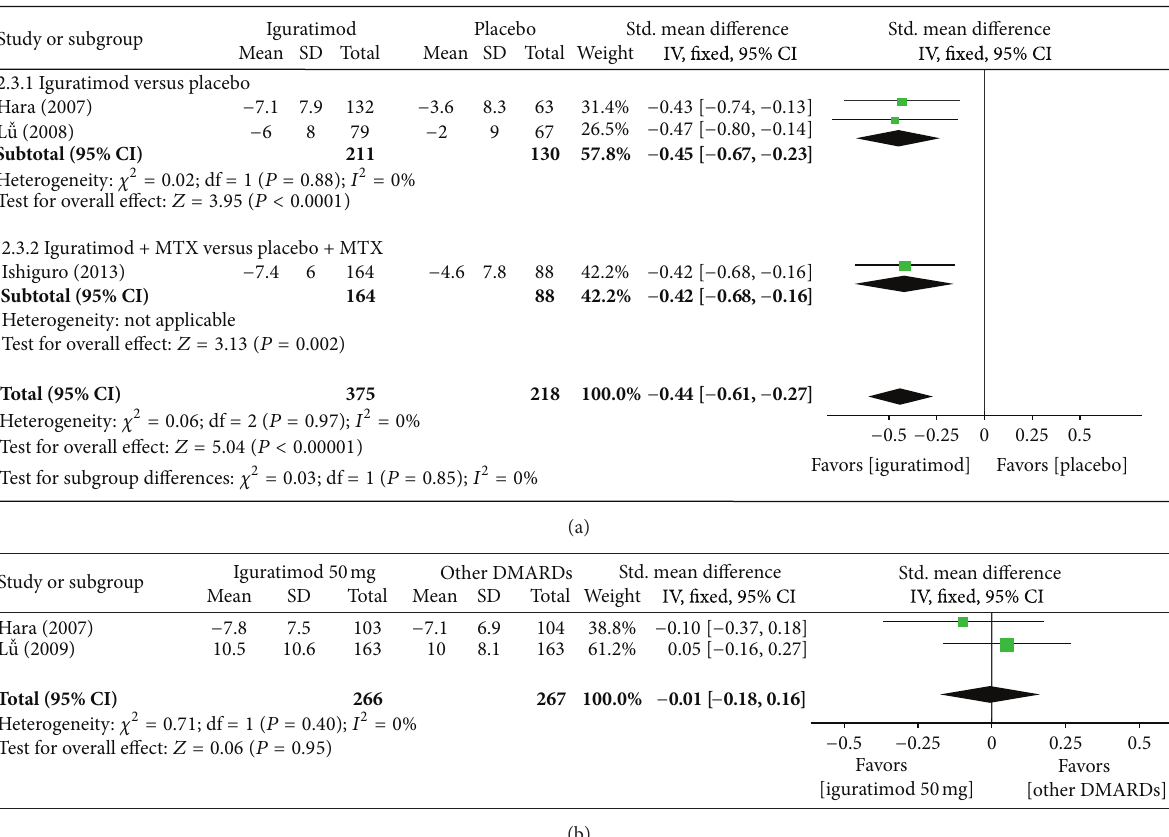
Figure 5: (a) Comparison of tender joint count between iguratimod and placebo groups. (b) Comparison of tender joint count between iguratimod and other DMARDs (MTX and SASP)